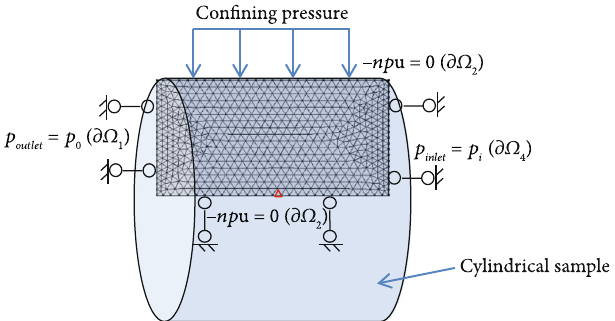
Figure 9: A model of gas injection into coal under constant con fi ning stresses. Position of red triangle is value point of Table 2: Physical parameters used in the numerical simulation. Symbol